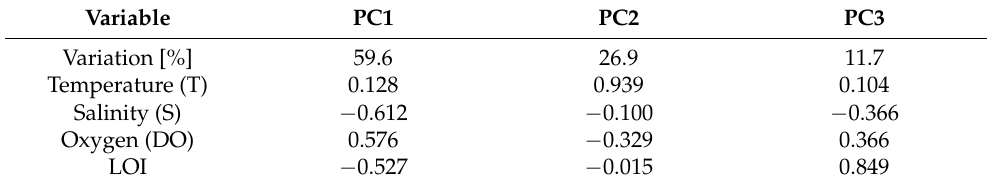
Figure 2. Results of principle component analysis (PCA). Variables included in the PCA are bottom water temperature (T), salinity (S) and oxygen concentration (DO), and organic matter content in the surface sediments (LOI). Table 2. Percentage of variation and coefficients in the linear combinations of variables forming PCs.